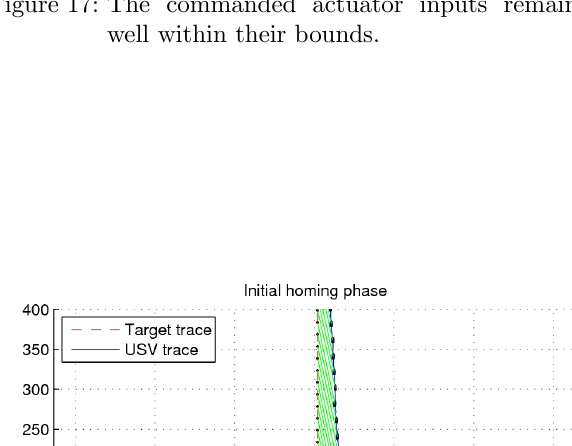
Figure 17: The commanded actuator inputs remain well within their bounds.